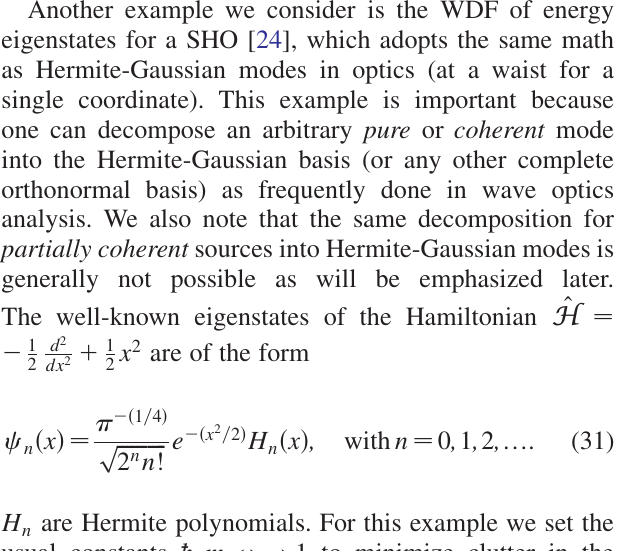
ð x Þ offset by n